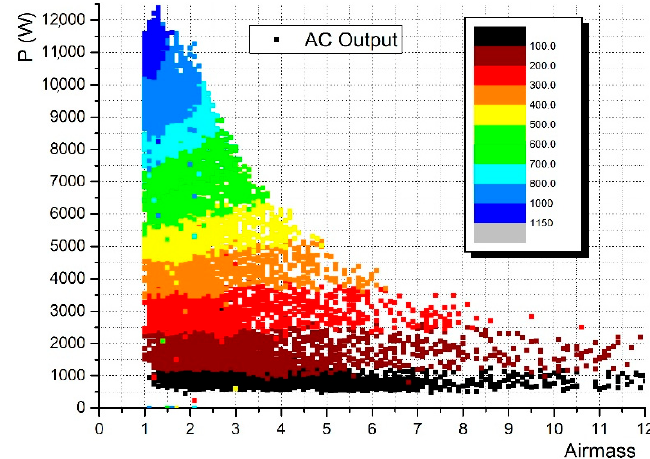
Figure 8. Correlation between AC power output, airmass, and irradiance.